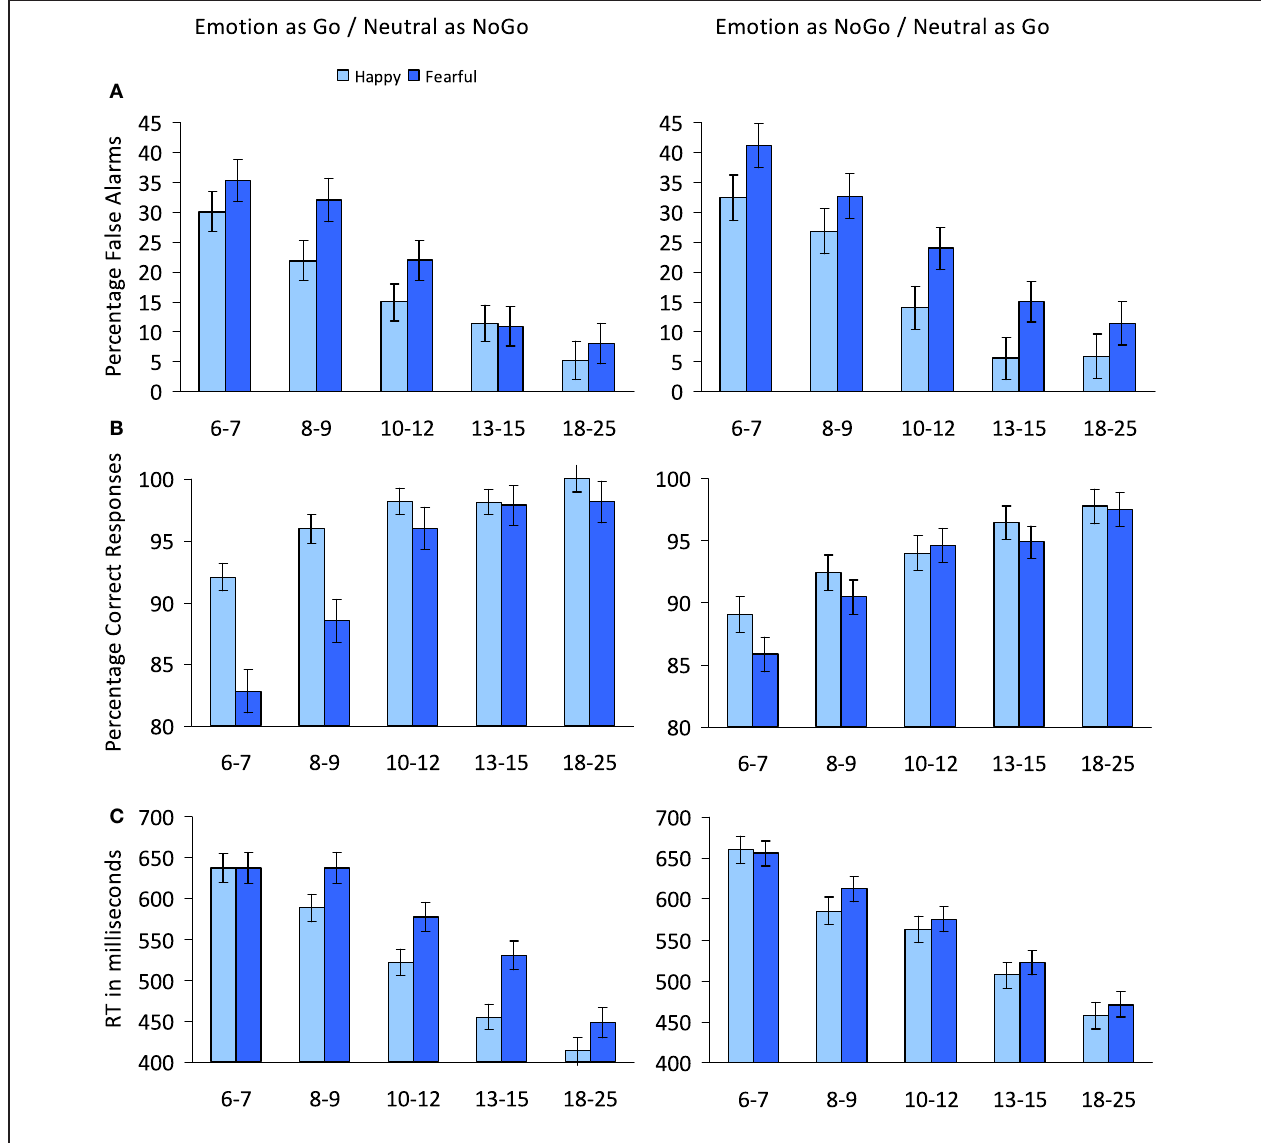
plotted separately for the blocks in which the emotional face was the go- vs. the nogo-stimulus. (C) Developmental decrease in RTs to happy and fearful faces plotted separately for the blocks in which the emotional face was the go- vs. the nogo-stimulus. Note that happy and fearful faces were presented in separate blocks, paired with neutral faces (see text for